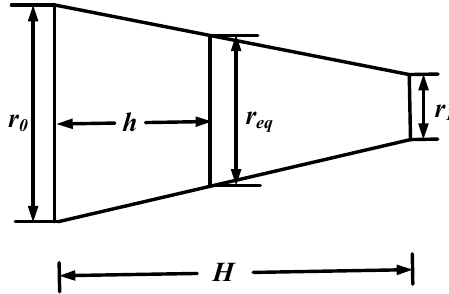
Figure 5. Equivalent radius of the vertical infinitesimal element of the tower.